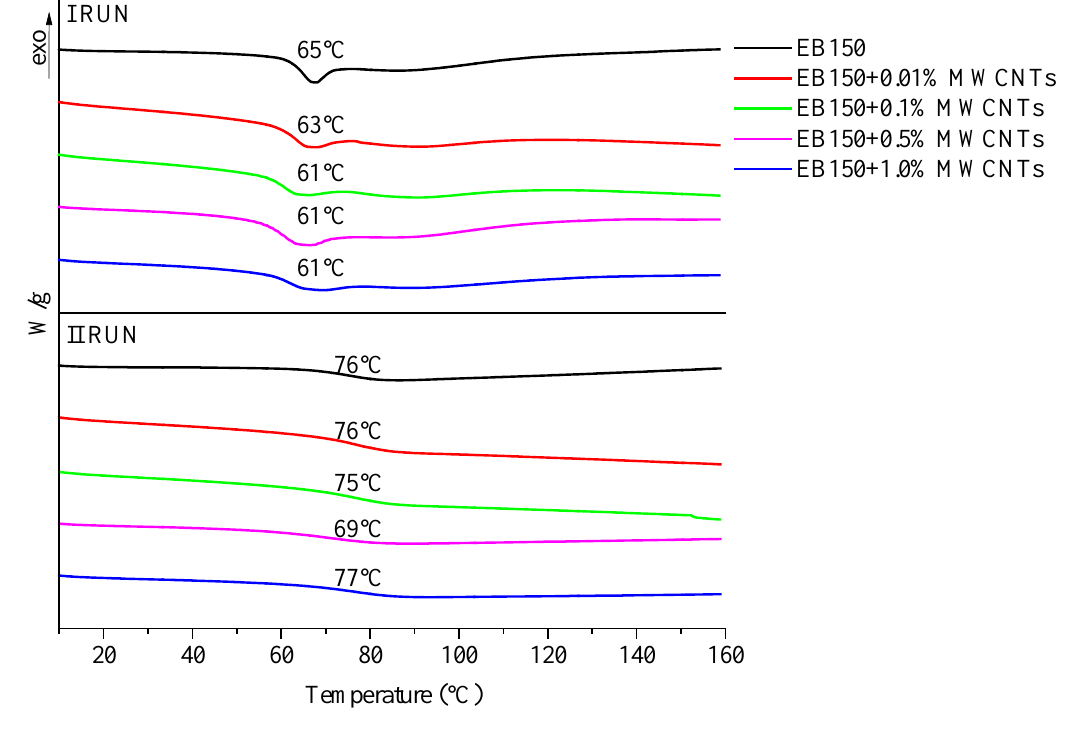
Figure 8. DSC traces (1st and 2nd heating up) for UV-LED cured EB150 and its composites with different MWCNTs loadings.